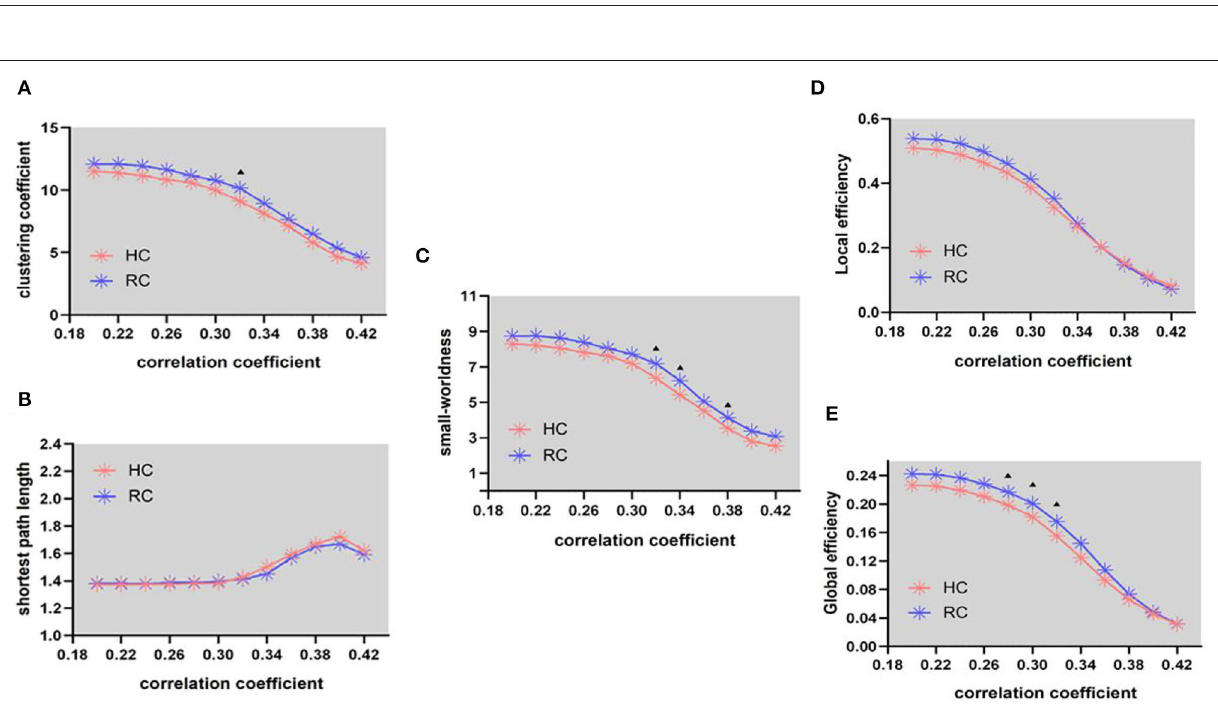
FIGURE 1 | Functional connectivity network at different sparsity for patients with RC (the blue line) and controls (the pink line) and their statistical comparison results ( p < 0.05 5,000 permutation test, FDR correction). (A) Gamma, (B) lambda, (C) sigma, (D) local efficiency, and (E) global efficiency. The black triangles indicate a significant group difference.